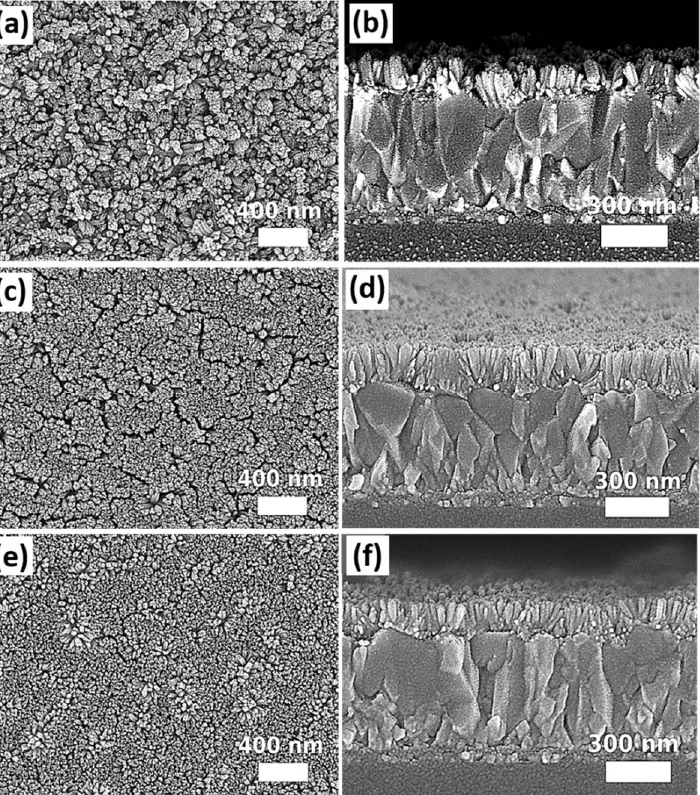
Figure 5. The top-view and cross-sectional SEM images of SnO 2 nanorod arrays grown on different types of seed layers: ( a , b ) SnO 2 thin film prepared by the magnetron sputtering, ( c , d ) SnO 2 nanoparticles prepared by spin coating of suspension solution, and ( e , f ) SnO 2 quantum dots prepared via a sol-gel process.